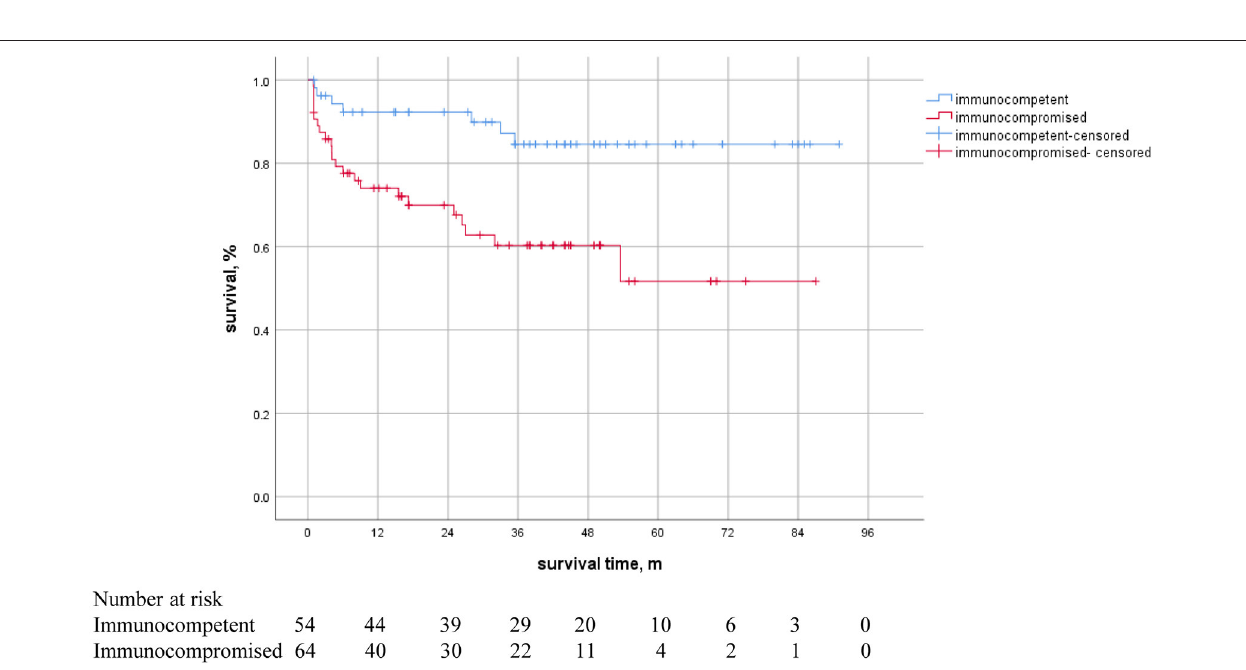
FIGURE 3 | Comparison of the Charlson Comorbidity Index score between immunocompetent and immunosuppressive patients with NTM infections.